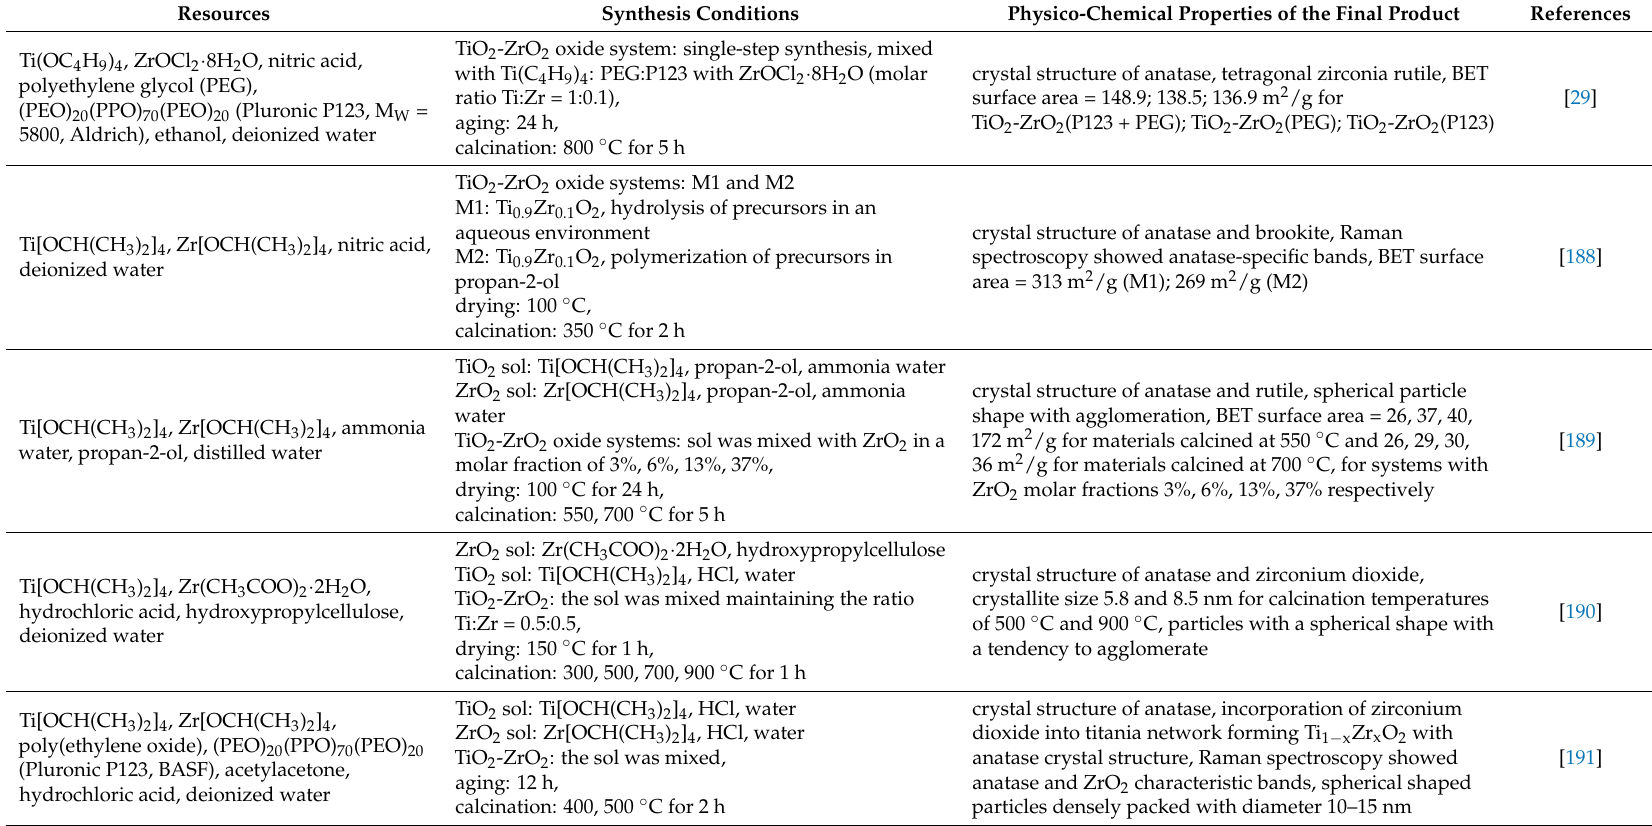
Table 5. Resources, synthesis conditions and physico-chemical properties of TiO 2 -ZrO 2 oxide systems obtained by the sol-gel